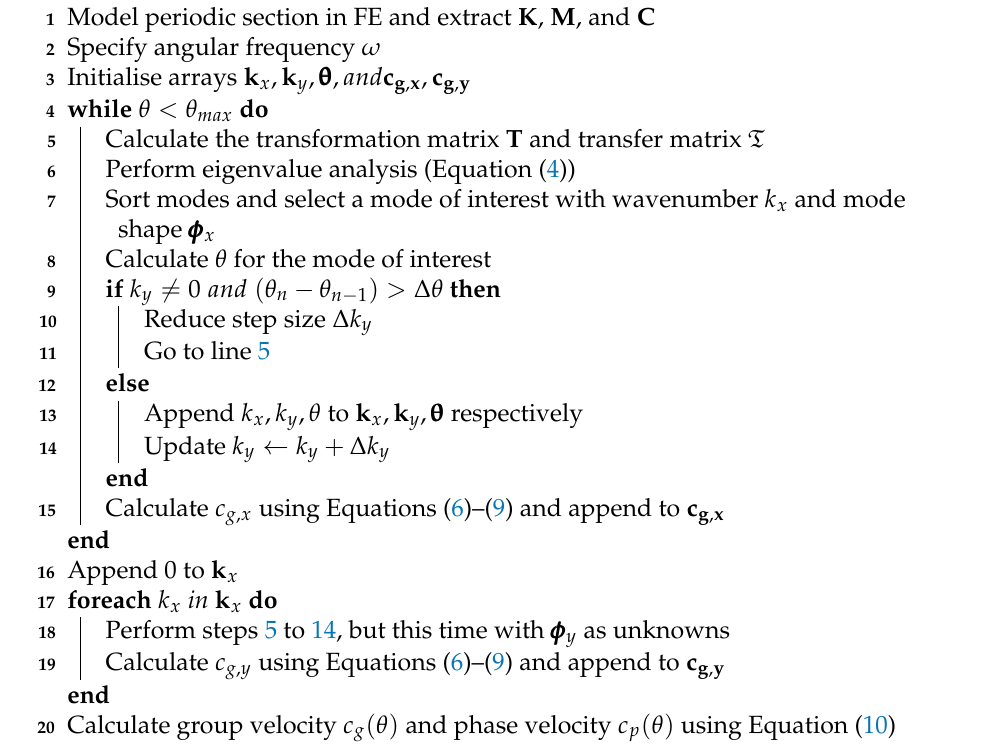
Algorithm 1: Group and phase velocity